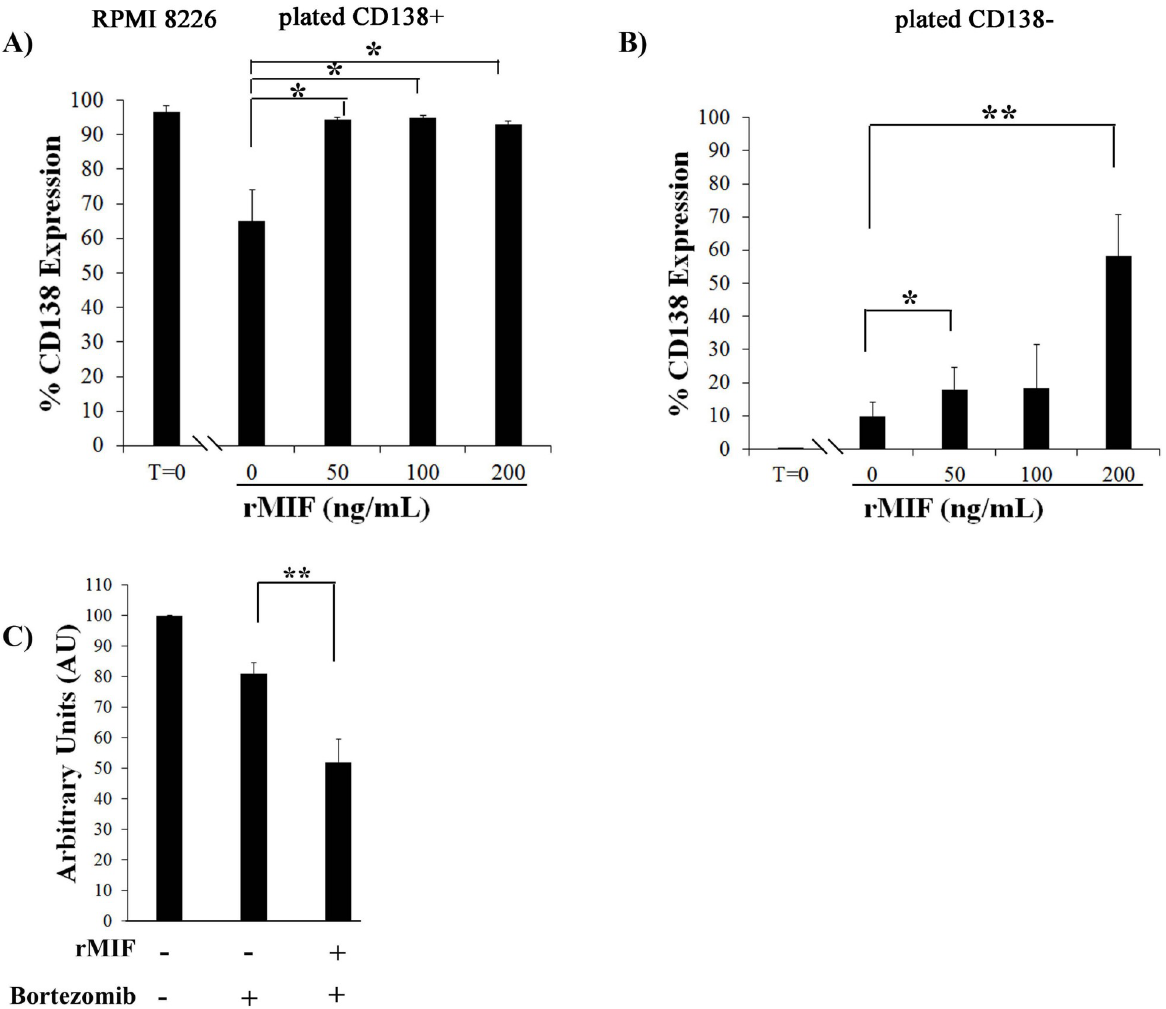
Fig 6. rMIF promotes the differentiation and maintenance of RPMI 8226 CD138+ cells. A) Sorted CD138+ and B) CD138- cells were plated, treated with increasing concentrations of rMIF for 24 h. Cells were stained with CD138 and PI and the CD138 content of viable (PI negative) cells is plotted (N = 3). T = 0 is CD138 content at time of plating. C) Sorted CD138- cells were plated and untreated (lane 1), treated with Bortezomib. (lane 2), or treated + rMIF and Bortezomib for 24 h (lane 3). The MTT assay used to assess viability of the different populations, mean absorbance values of untreated cells (lane 1) was set to 100 (N = 3). �� p < 0.001 t-test with Satterthwaite corrections to allow for possible unequal variances. Error bars, mean ±